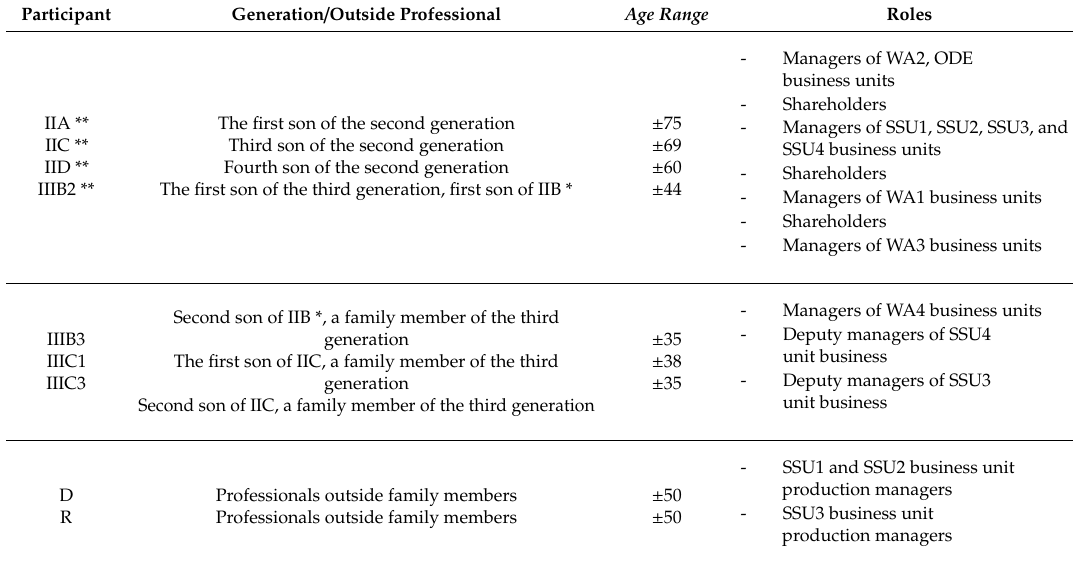
Table 3. Participant data and roles.